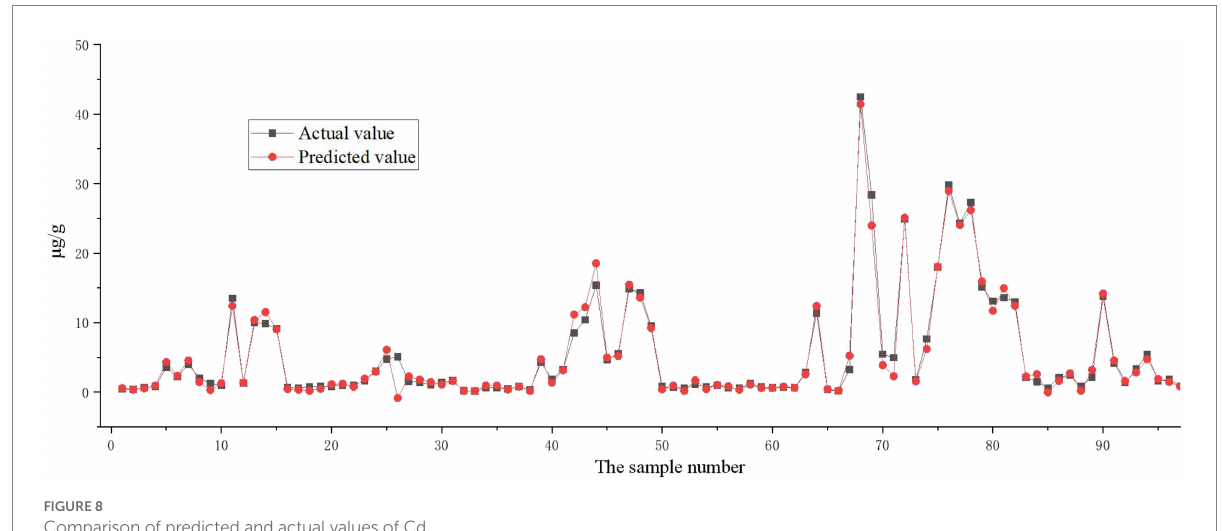
FIGURE 8 Comparison of predicted and actual values of Cd.